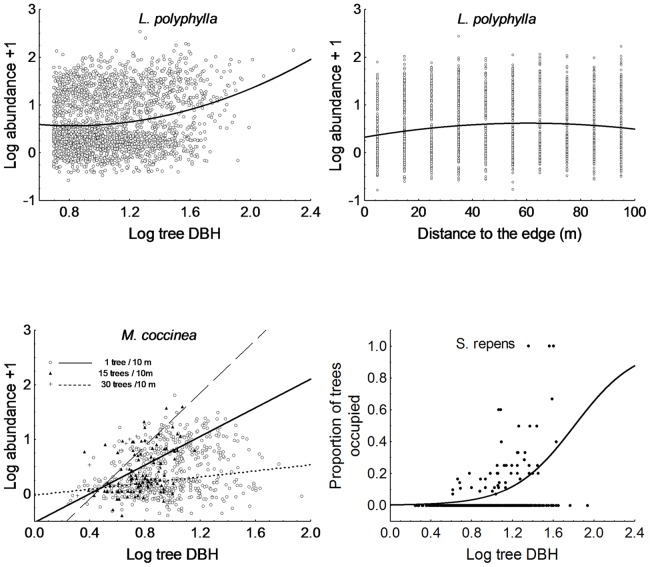
Partial residual plots showing the effects of within-patch habitat characteristics on the abundance of different species.(a) and (b) Luzuriaga polyphylla, (c) Mitraria coccinea, and (d) Sarmienta repens. Graph (c) shows the relationship between epiphyte abundance and Log(tree DBH) for several values of tree density.